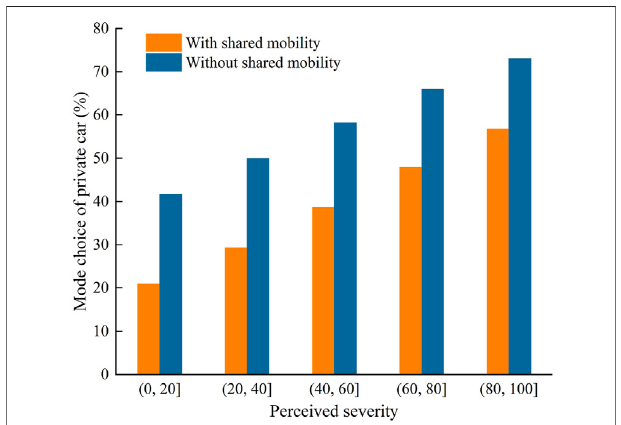
FIGURE 4 | Predicted mode split of private car in response to the perceived COVID-19 severity.